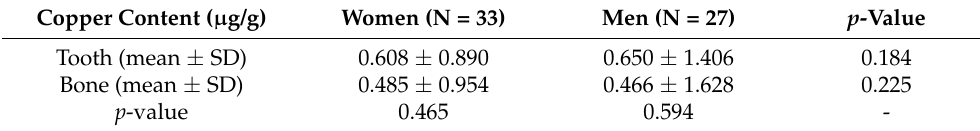
Table 22. Copper content in tested samples taken from patients of different sexes.